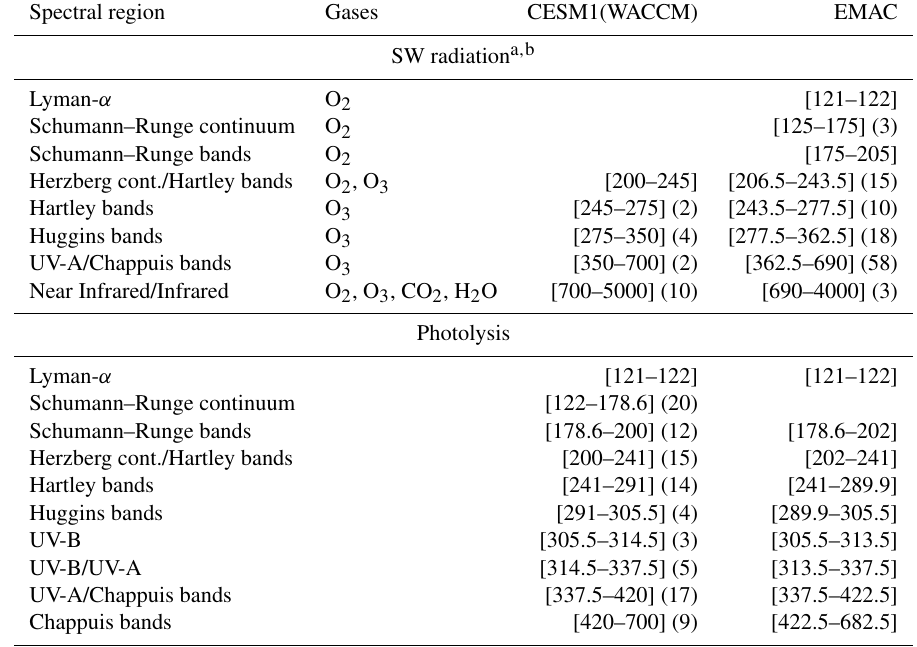
Table 3. Summary of spectral resolution of the SW radiation and photolysis schemes in EMAC and CESM1(WACCM). Boundaries of spectral intervals and further refinement in brackets when larger than